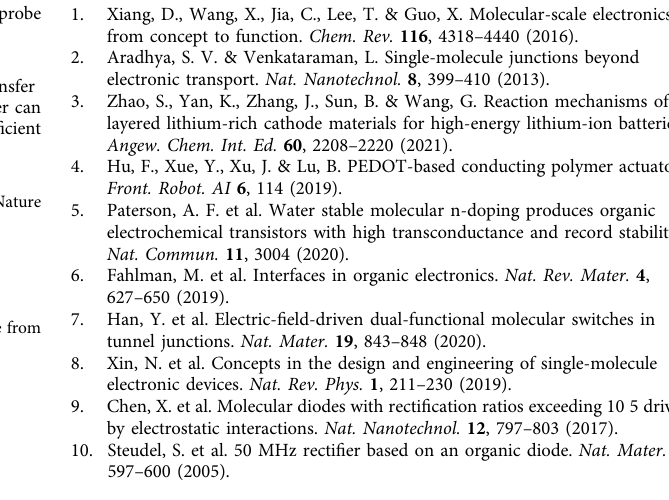
station, with the tube electrode grounded.